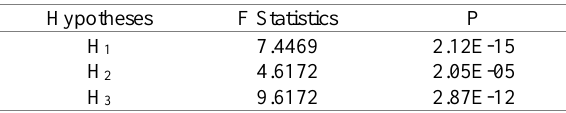
Table 15. Panel homogeneity test results of Model 3 Hypotheses